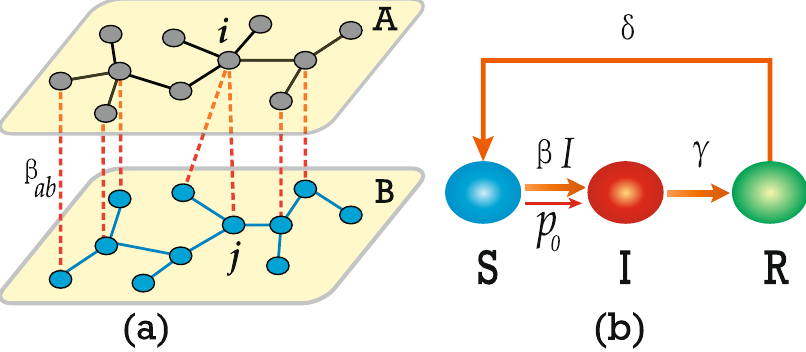
Figure 2. Schematic figure of the epidemic model to reproduce the synchronized and mixed outbreak patterns. ( a ) Schematic figure of the two-layered network, where the “black”, “blue” and “red” lines represent the links of the networks , A B and the inter-network AB , respectively. β ab denotes the infectious rate through one interconnection between and A B . (b) Schematic figure of the extended SIRS model for each node in and A B , where the symbols S , I and R represent the susceptible, infectious, and refractory states, respectively, and the parameters β , γ and δ represent the infectious, refractory and recovery rates, respectively. p 0 denotes the probability for a susceptible node to be naturally infected by environment or other